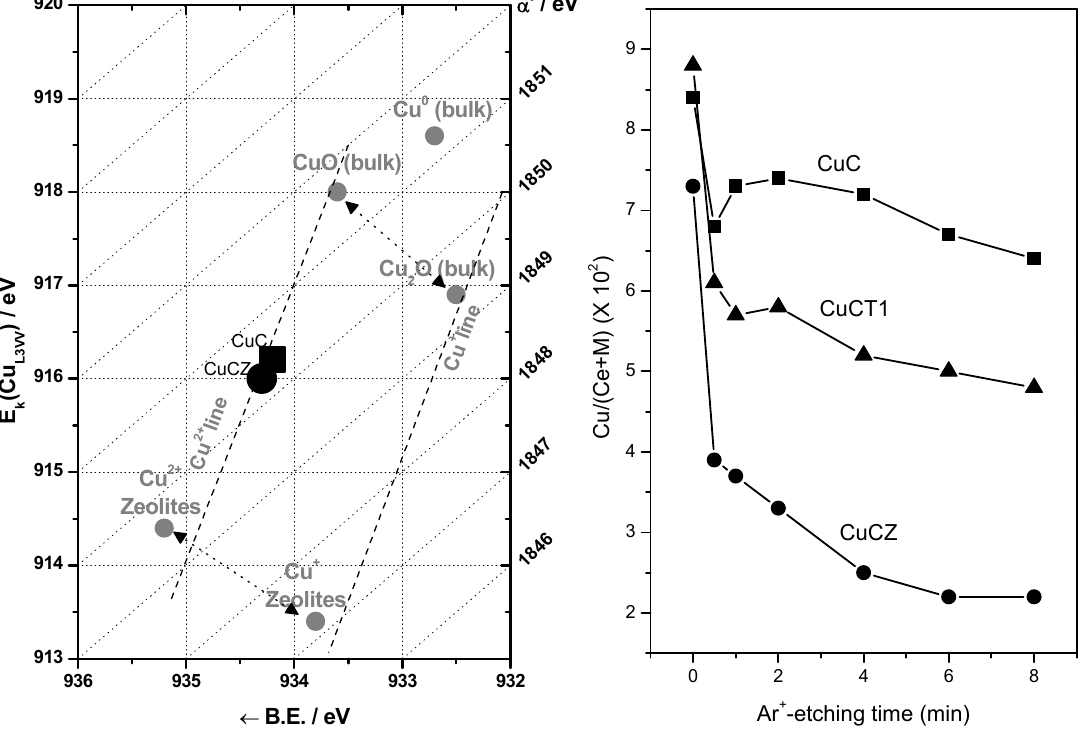
Figure 2. Left: Wagner diagram showing Cu (2p and AES) XP parameters observed for CuC and CuCZ samples. Right: Profile of the Cu/(Ce + M), M = Zr or Tb, atomic ratio as a function of the Ar + -sputtering time for the indicated samples. Note: This figure is adapted with permission from [18]. Copyright © 2005, Elsevier B.V.